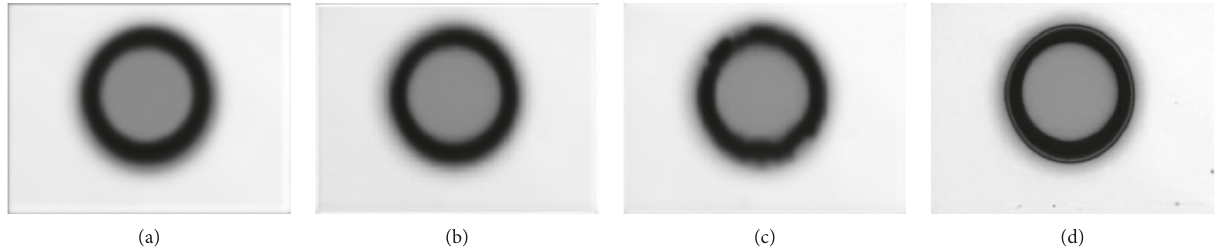
Figure 6: CAE network.